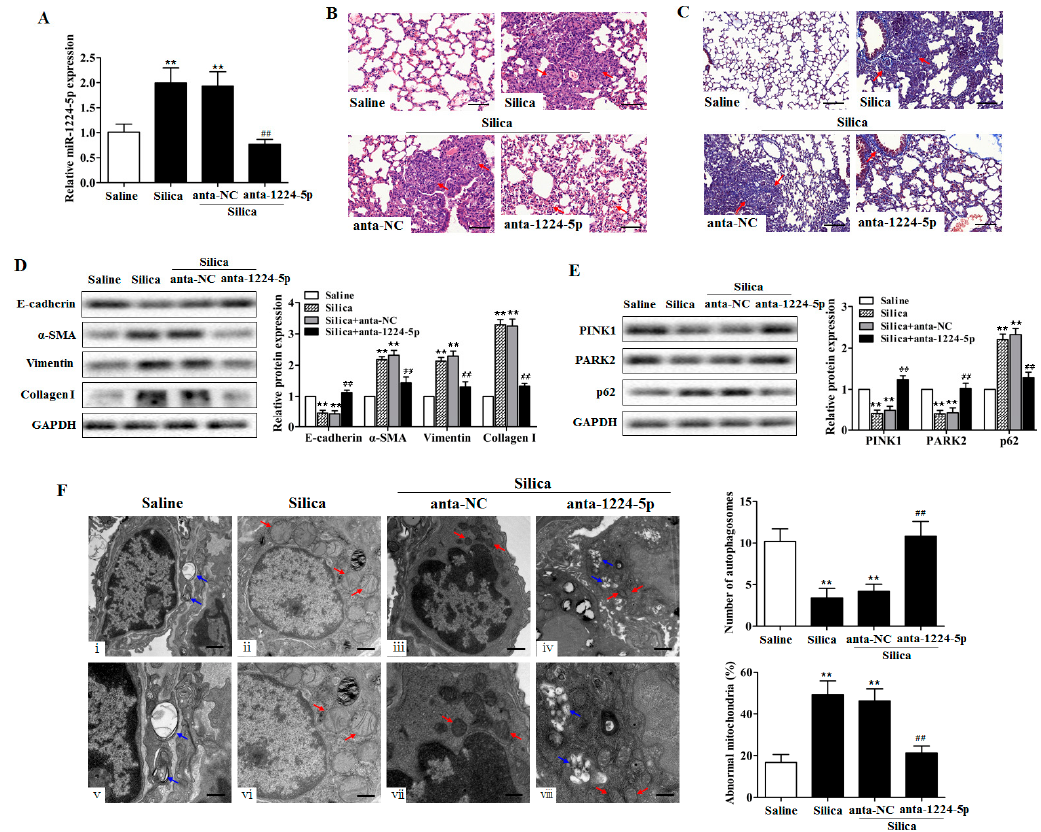
Figure 2. Down-regulated miR-1224-5p attenuates silica-induced pulmonary fibrosis and restores mitophagy in vivo. ( A ) qRT-PCR analysis of miR-1224-5p levels in mouse lung tissues after injection of saline, silica, silica plus antagomir negative control (anta-NC), and silica plus miR-1224-5p antagomir (anta-1224-5p) for 28 days, with ** p < 0.01 vs. the saline group and ## p < 0.01 vs. the silica plus anta-NC group; ( B ) The lung histological lesions were observed with haematoxylin and eosin (H&E) staining. Red arrows indicate fibrotic foci and destruction of alveolar architecture. Scale bar: 100 µm; ( C ) Collagen deposition in lung tissues were observed by Masson’s trichrome staining. Red arrows indicate collagen deposition. Scale bar: 100 µm; ( D ) Western blot and densitometric analysis of E-cadherin, α -SMA, Vimentin and Collagen I expression in mouse lung tissues, with ** p < 0.01 vs. the saline group and ## p < 0.01 vs. the silica plus anta-NC group; ( E ) Western blot and densitometric analysis of PINK1, PARK2, and p62 expression in mouse lung tissues, with ** p < 0.01 vs. the saline group and ## p < 0.01 vs. the silica plus anta-NC group; ( F ) Transmission electron microscopy detection of mitochondrial structure and vacuoles of fibroblasts in mouse fibrotic lung tissues. Blue arrows indicate autophagic vacuoles. Red arrows indicate abnormal mitochondria. Quantification of autophagosomes and percentage of abnormal mitochondria (swollen with an irregular shape and disorganized cristae) from electron microscopy images were performed (five cells each group), with ** p < 0.01 vs. the saline group and ## p < 0.01 vs. the silica plus anta-NC group. Scale bars, 1 µm (upper panels) and 500 nm (lower panels). All data are expressed as the mean ± SD of at least three independent experiments.